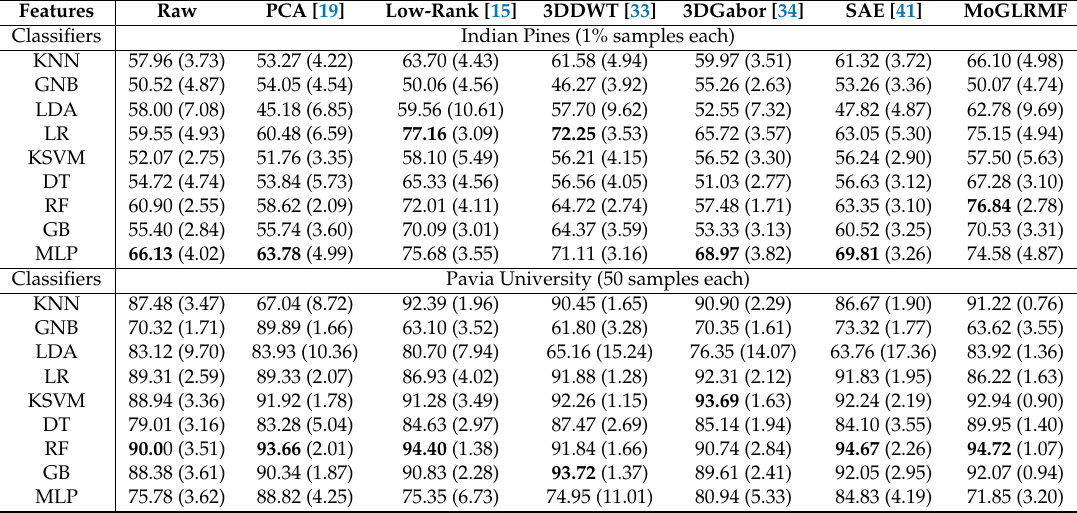
Table 3. Mean classification overall accuracy (OA) and standard deviation (std) (%) of all the combination of features and classifiers on two benchmark datasets using SHIP package. The best result for each feature is highlighted in